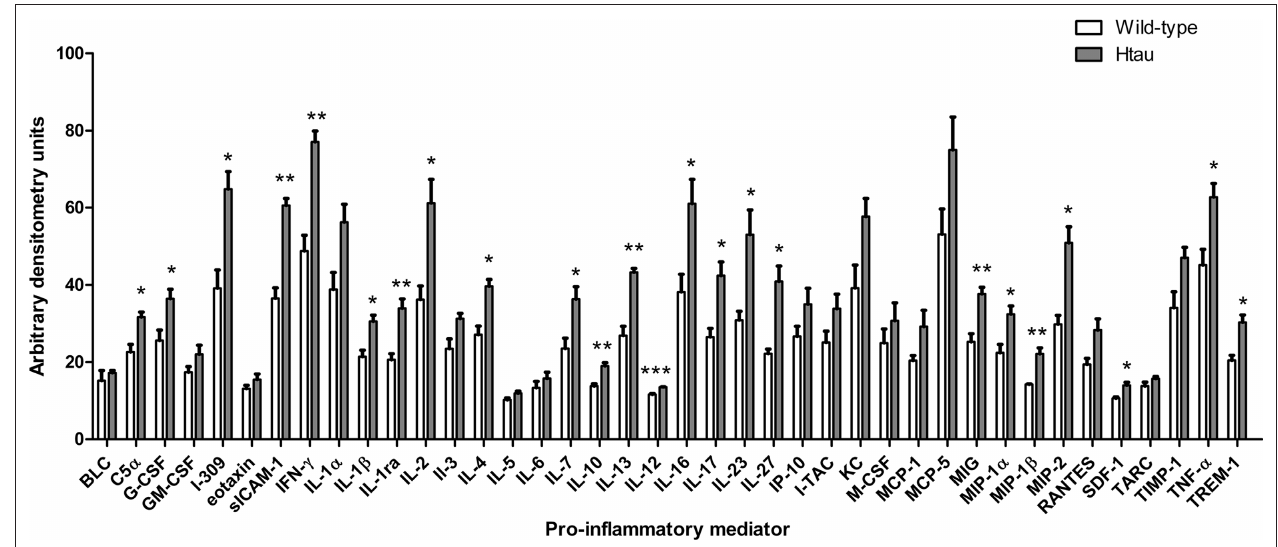
Figure 3 | Cytokine amounts in the cortex of htau and wild-type mice. Bar chart shows cytokine protein amounts in arbitrary densitometry units. Values represent mean ± SEM, * p < 0.05, ** p < 0.01, *** p < 0.001. n =